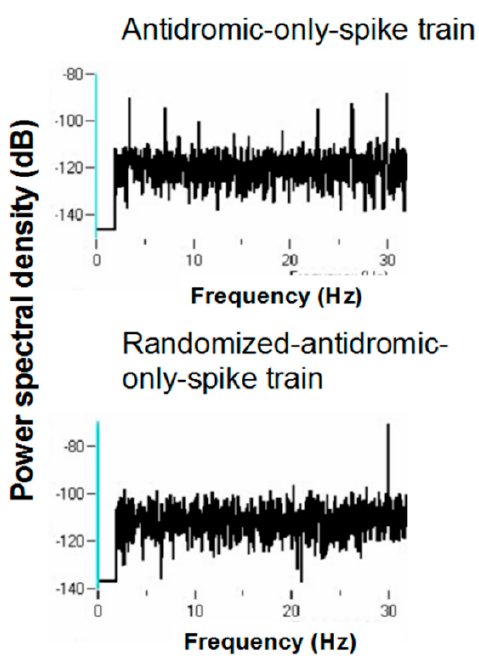
Figure 19. Representative power spectral density of a antidromic-only spike train and its randomized-only spike train counterpart for 30 pps DBS.